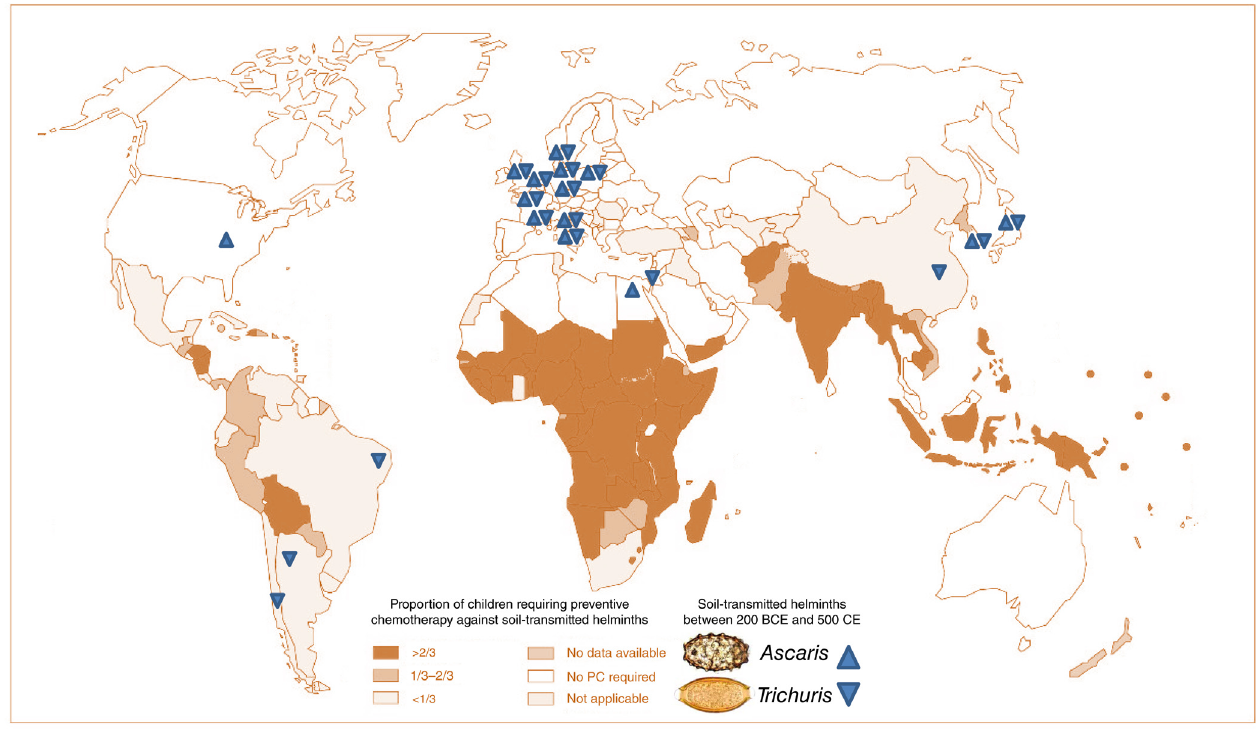
Figure 1. Multiple geographical and historical investigation bias between ancient settlements claimed to be infected in the past, and children’s helminthiases in modern countries. Background map implemented with palaeoparasitological records of roundworms ( Ascaris ) and whipworms ( Trichuris ) recovered from a global selection of archaeological sites built between 200 BCE and 500 CE (Common Era) 2,4–8 . The background map has been adapted from World Health Organization, program on Control of Neglected Tropical Diseases (gamapserver.